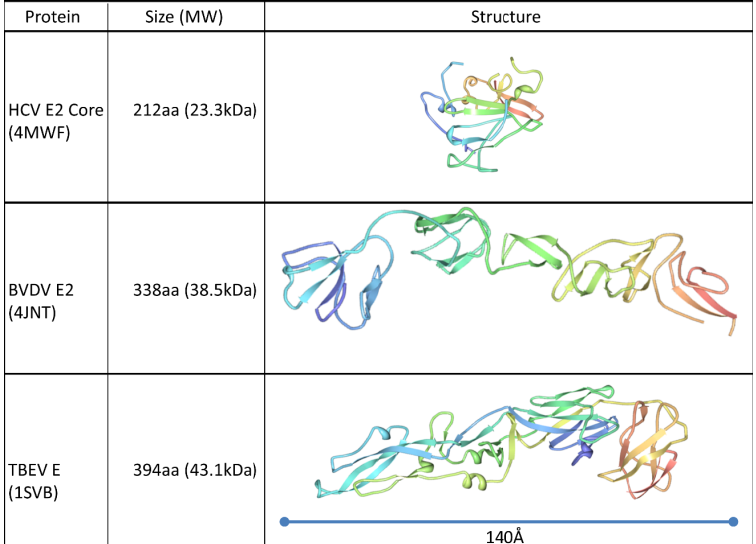
Figure 1. Comparison of the structures of the HCV E2 glycoprotein core [42] with the crystal structures of Bovine Viral Diarrhoea Virus E2 glycoprotein [48] and Tick-Borne Encephalitis virus E glycoprotein [67]. The resolved crystal structure of HCV E2 revealed a much more compact protein structure than that of other members of the family Flaviviridae. Protein ribbons are coloured from the N-terminus (blue) through to the C-terminus (red). The PDB ID numbers are indicated in brackets.